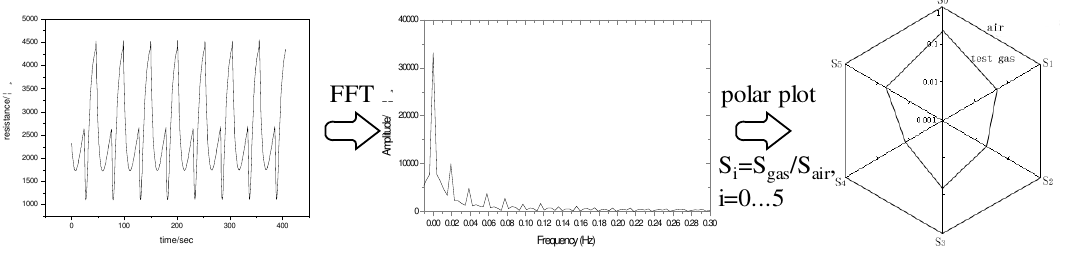
Figure 7. Illustration showing the way in which the polar plots were constructed. Sensor variables used: the amplitude corresponding to 0Hz frequency, the amplitude corresponding to the fundamental frequency and the first four harmonics. The values in the polar plot were obtained by normalizing each component to the corresponding amplitude in